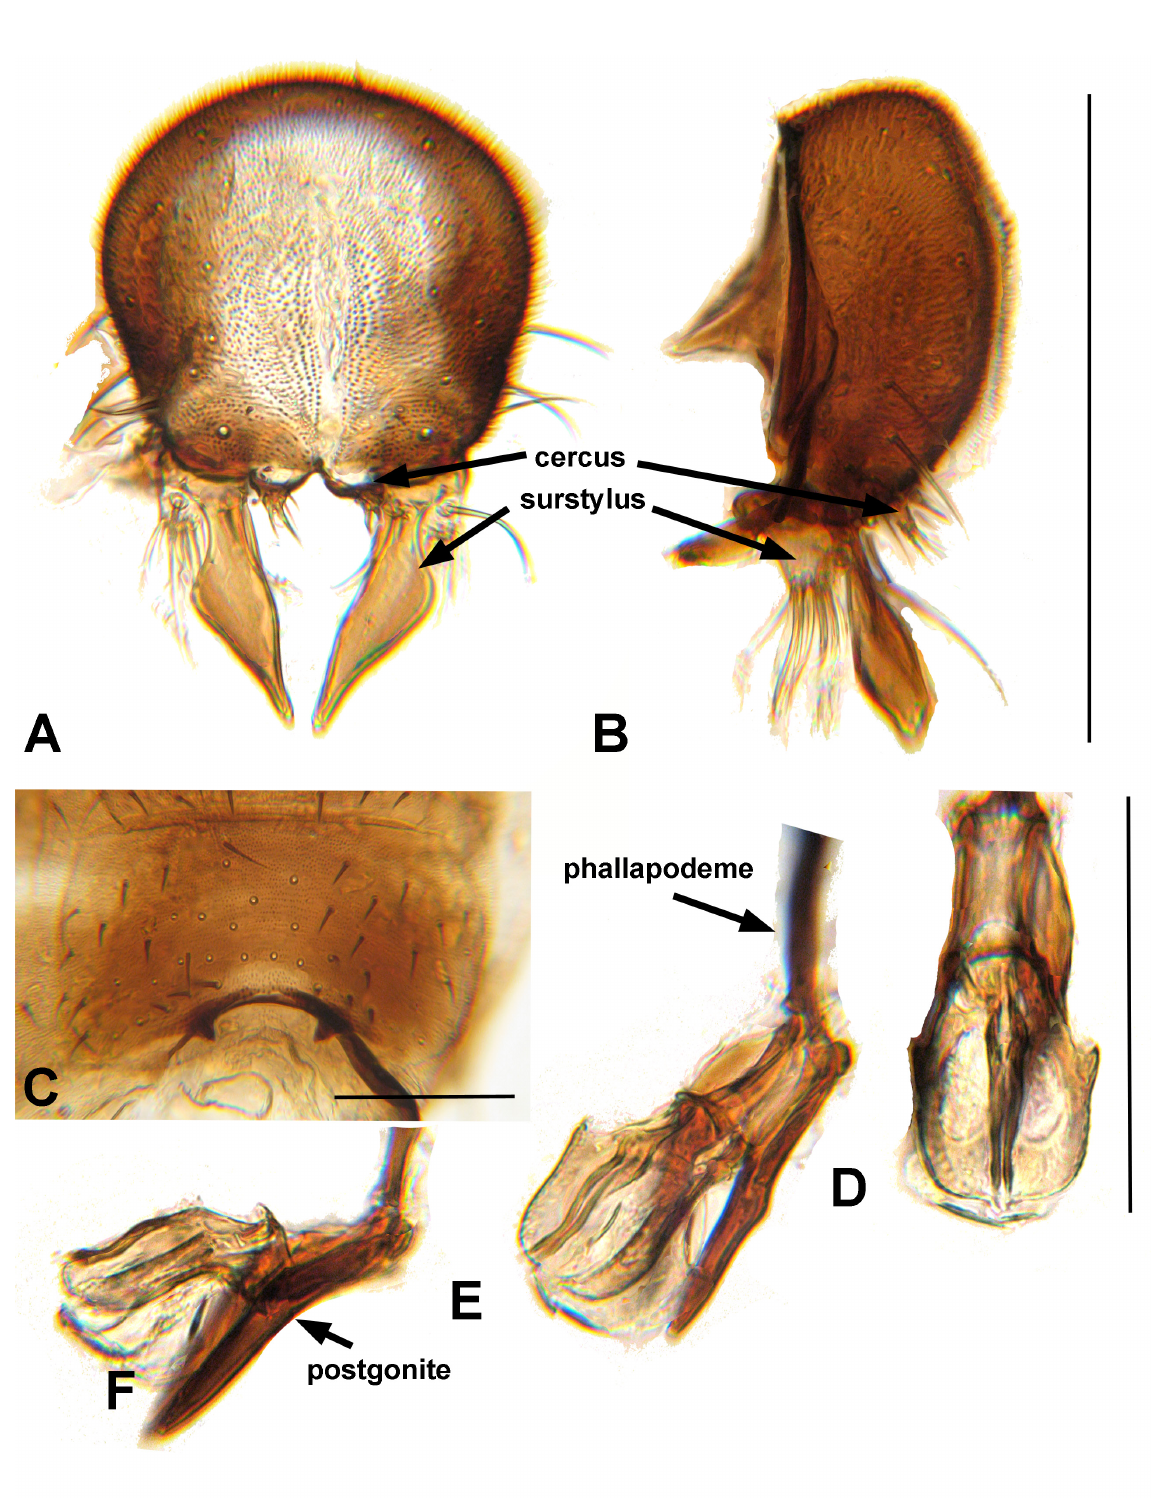
Fig. 19. Rudolfina remiforma sp. nov., male terminalia (debu01086286). A . Epandrium, surstylus and cercus, caudal view. B . Same as preceding, lateral view. C . Sternite 5, ventral view. D . Phallus and postgonites, dorsal view. E . Phallus, postgonites and phallapodeme, dorsolateral view. F . Same as preceding, lateral view. Scale bars: A–B = 0.25 mm; C = 0.10 mm; D–F = 0.08